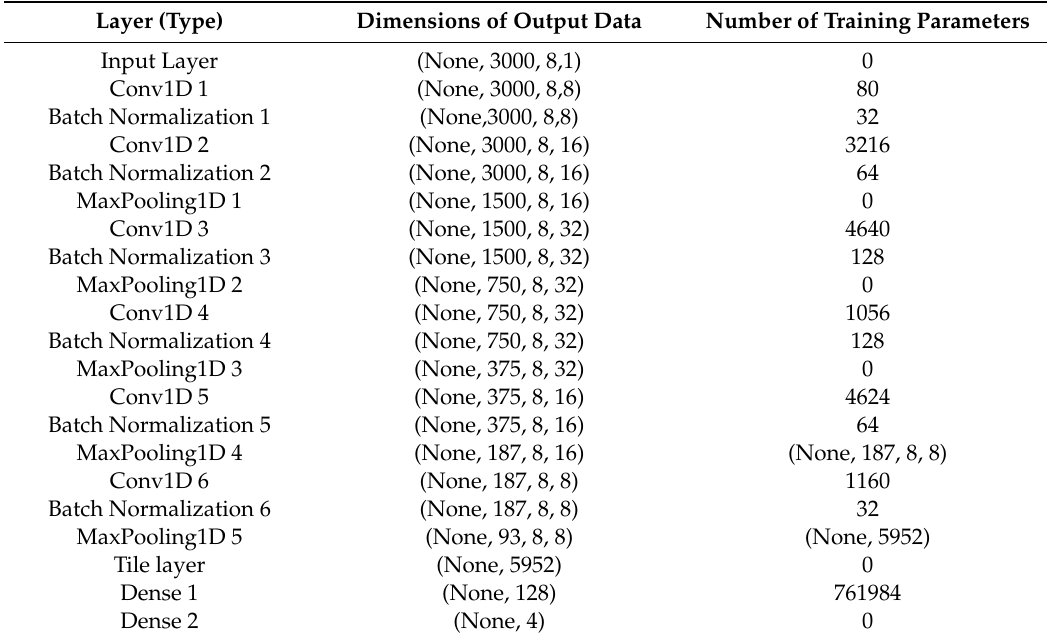
Table 3. 2-D CNN multi-measurement point reciprocating compressor gas valve fault diagnosis model structure.